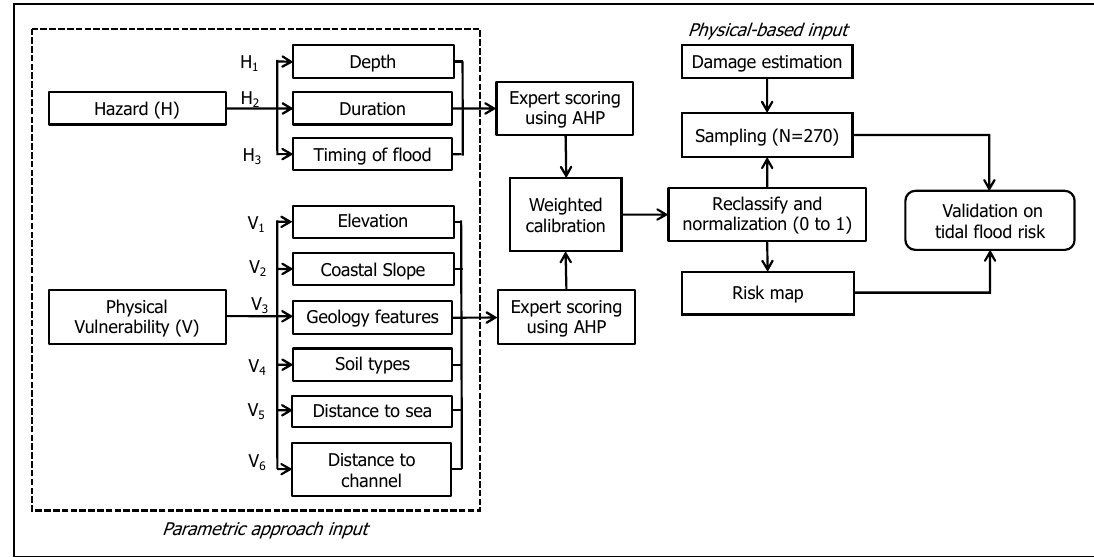
Figure 2. Framework of tidal-induced flooding risk assessment and comparison between parametric and physical-based approaches.